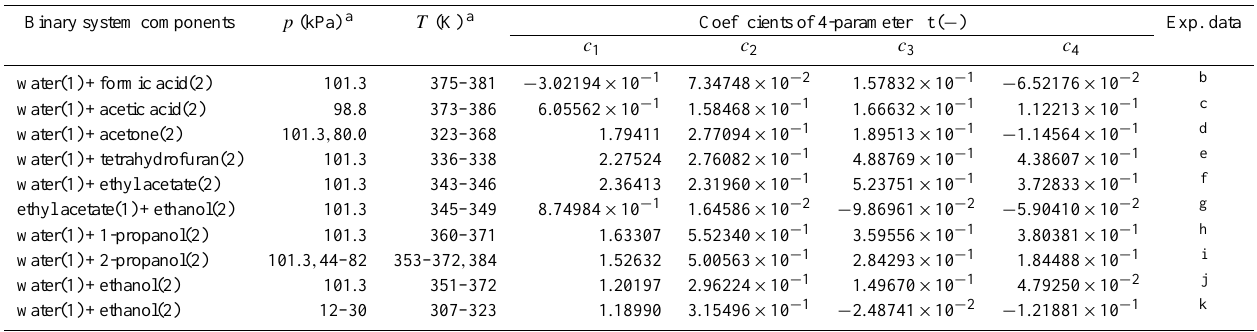
Table 1. Coefficients for the Gibbs-Duhem-Margules parameterization fitted to salt-free binary VLE data. Binary system